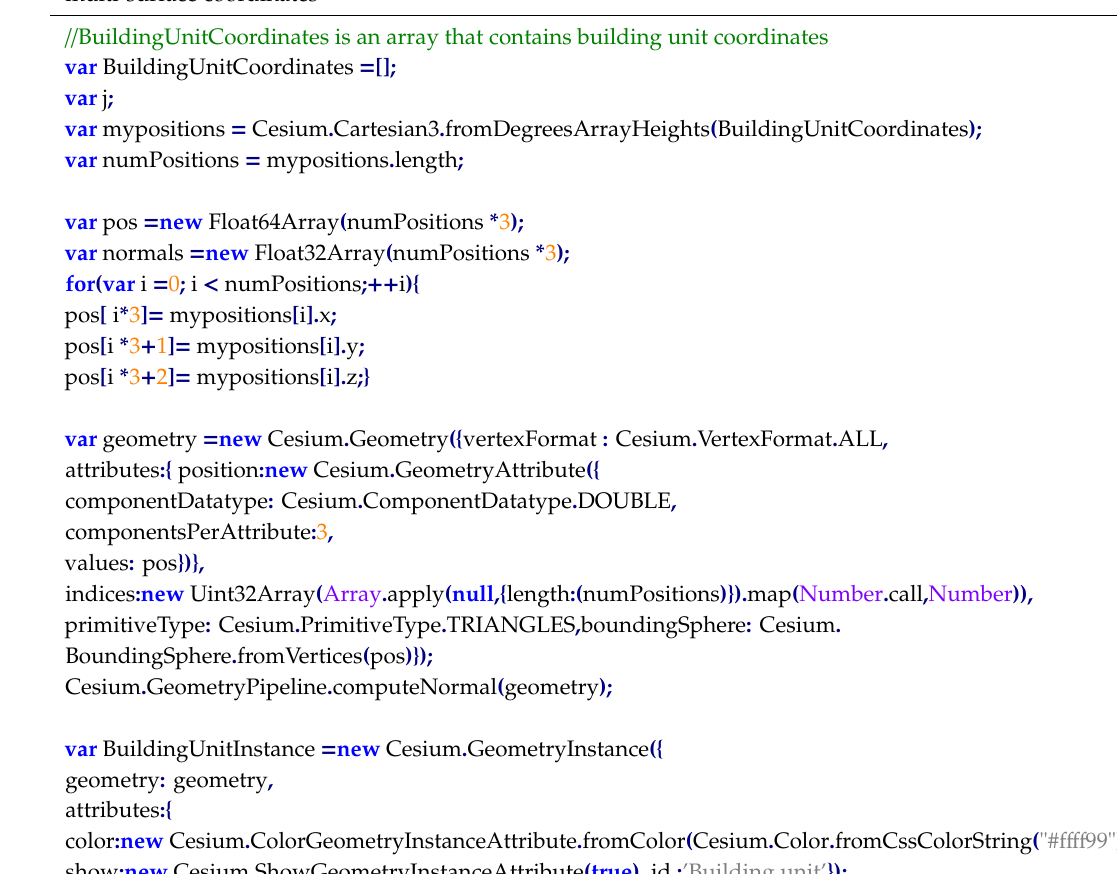
Algorithm 3: Code for visualization of a building unit by using Cesium Primitive API and an array of multi-surface coordinates